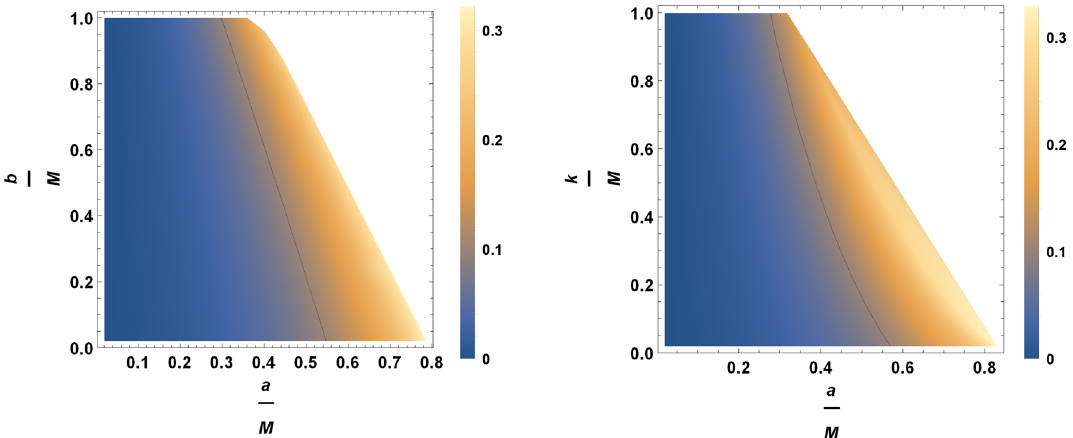
Fig. 18 The observable for deviation from circularity (cid:2) C as a function of black hole parameters. The left one is for l = 0 . 1 and k = 0 . 1. The right one is for l = 0 . 1 and b = 0 . 1. The angle of inclination is θ = 90 ◦ . The black lines in the figures correspond to (cid:2) C = 0 . 1